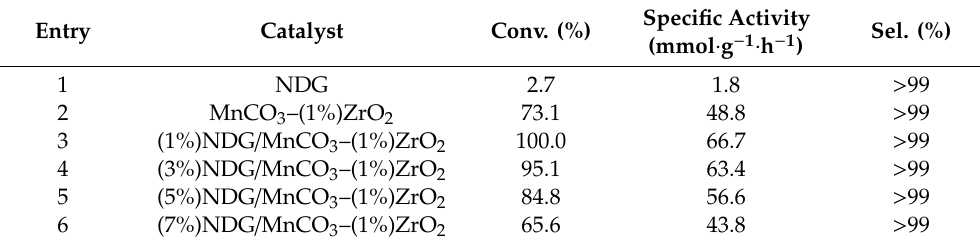
Table 2. Catalytic results of di ff erent